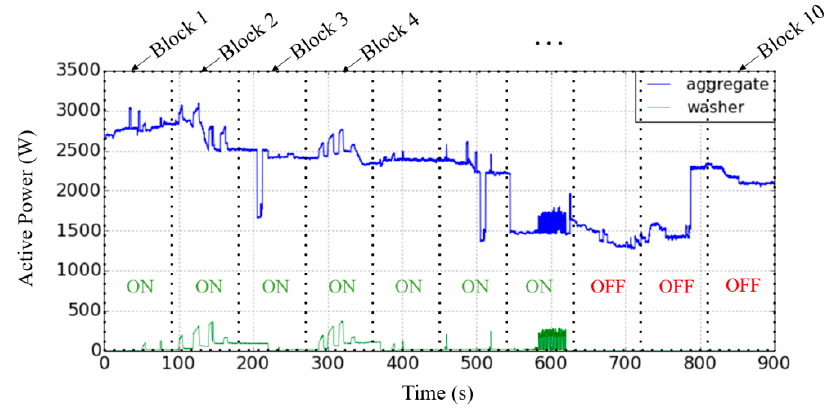
Figure 6. Defining 90-s blocks for binary classification and power usage regression.